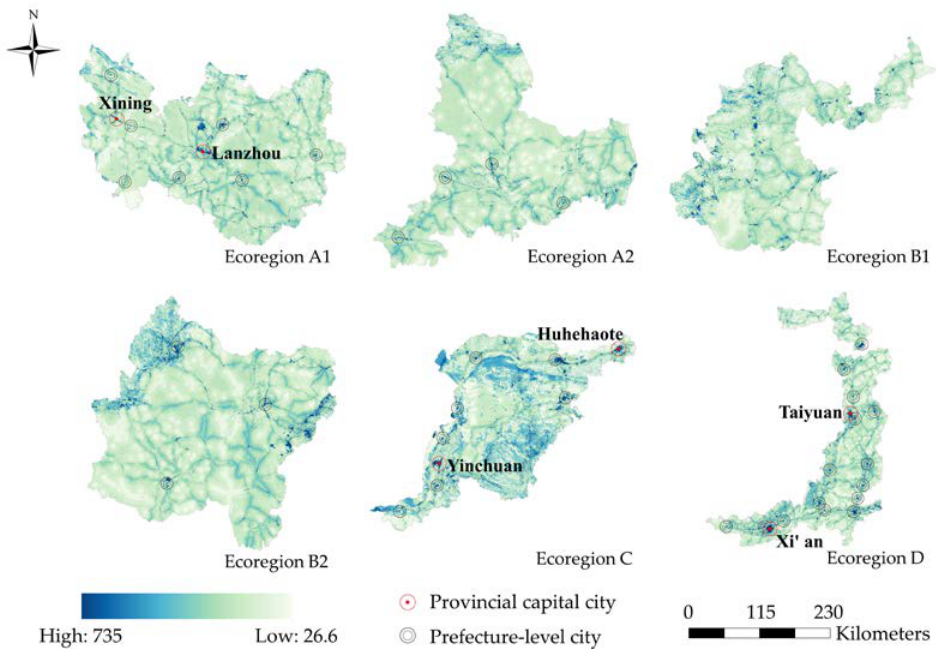
Figure 7. Spatial distribution of ecological resistance surface in each ecoregion.